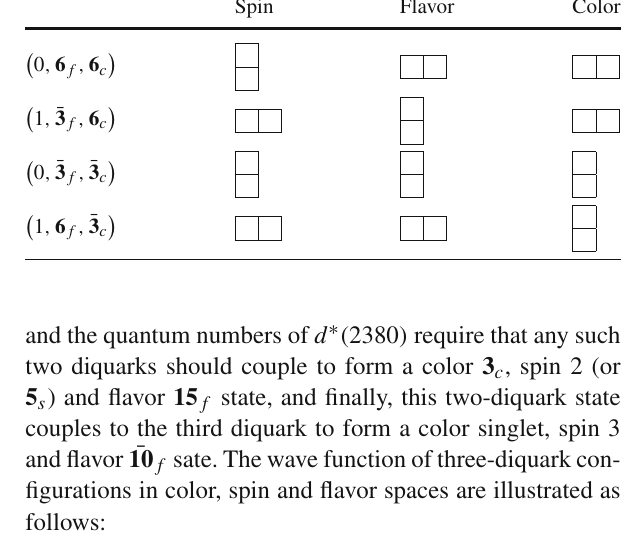
Table 1 Possible two-quark configurations Spin Flavor